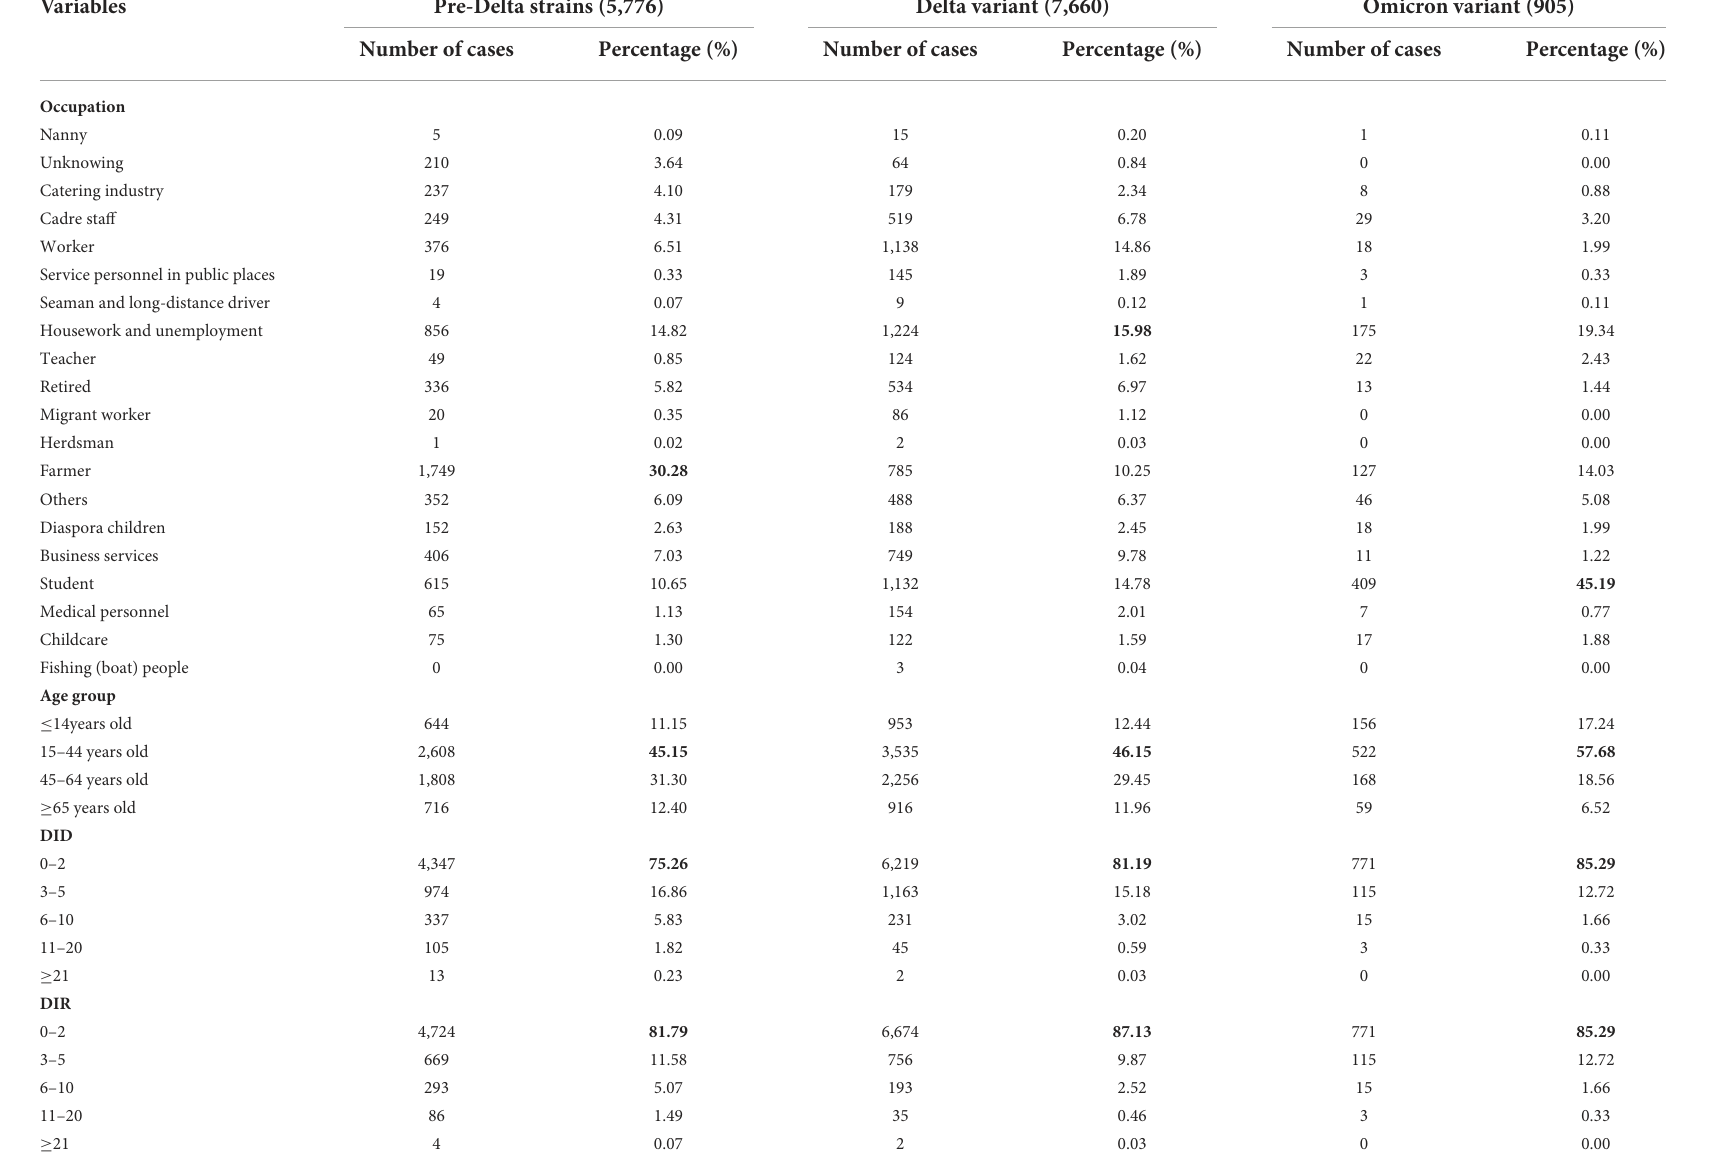
TABLE 2 Epidemiological characteristics of COVID-19 transmitted locally in